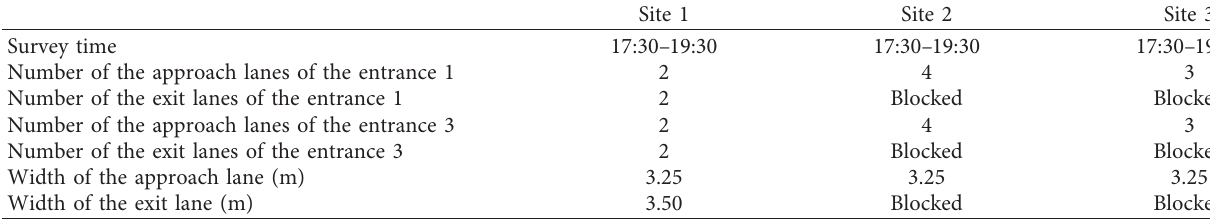
Table 1: Collected intersection and work zone data.